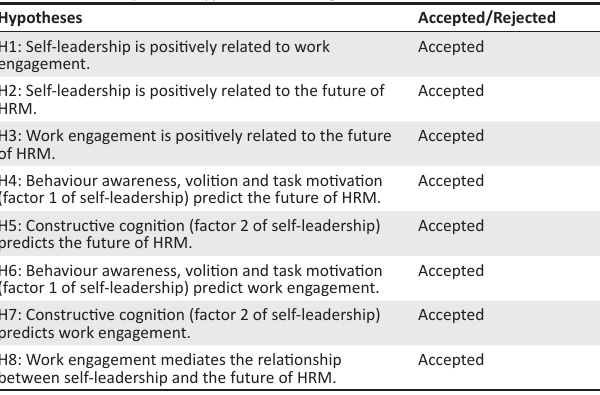
TABLE 6: Summary of the hypotheses testing.